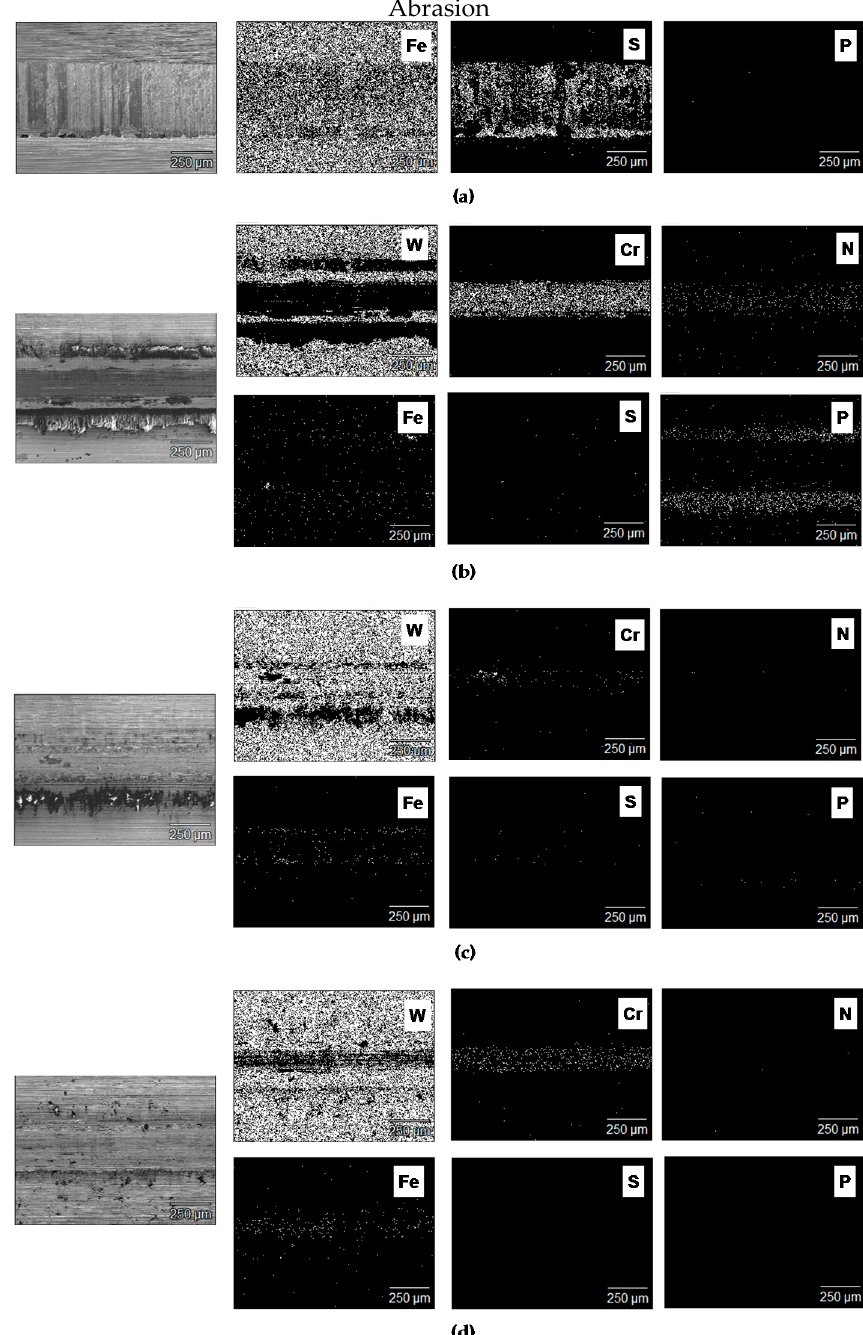
Figure 11. SEM images (on the left) and EDS surface analyses of the wear scars on the vee blocks: ( a ) Uncoated vee block lubricated with the mineral oil; ( b ) (W-DLC/CrN)-coated vee block lubricated with the mineral oil; ( c ) (W-DLC/CrN)-coated vee block lubricated with the PAO oil; and ( d ) (W-DLC/CrN)-coated vee block lubricated with the PAG oil.